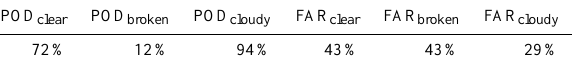
Figure 3. Instantaneous CFC by HSI (green), AVHRR (purple), SE- VIRI (red) at IMUK and SYNOP (blue) at HAJ for 15 July 2009. Upper HSI images show the sky at 8:00, 9:00, 11:50 and 12:00UTC (from left to right). Table 3. Contingency table comparing HSI and SEVIRI CFC for the cases of cloud-free (0–2 oktas), broken clouds (3–5 oktas) and cloud-covered (6–8 oktas). Values represent ratio between match- ups and the total of 957 valid measurements. Similar numbers are found for AVHRR.